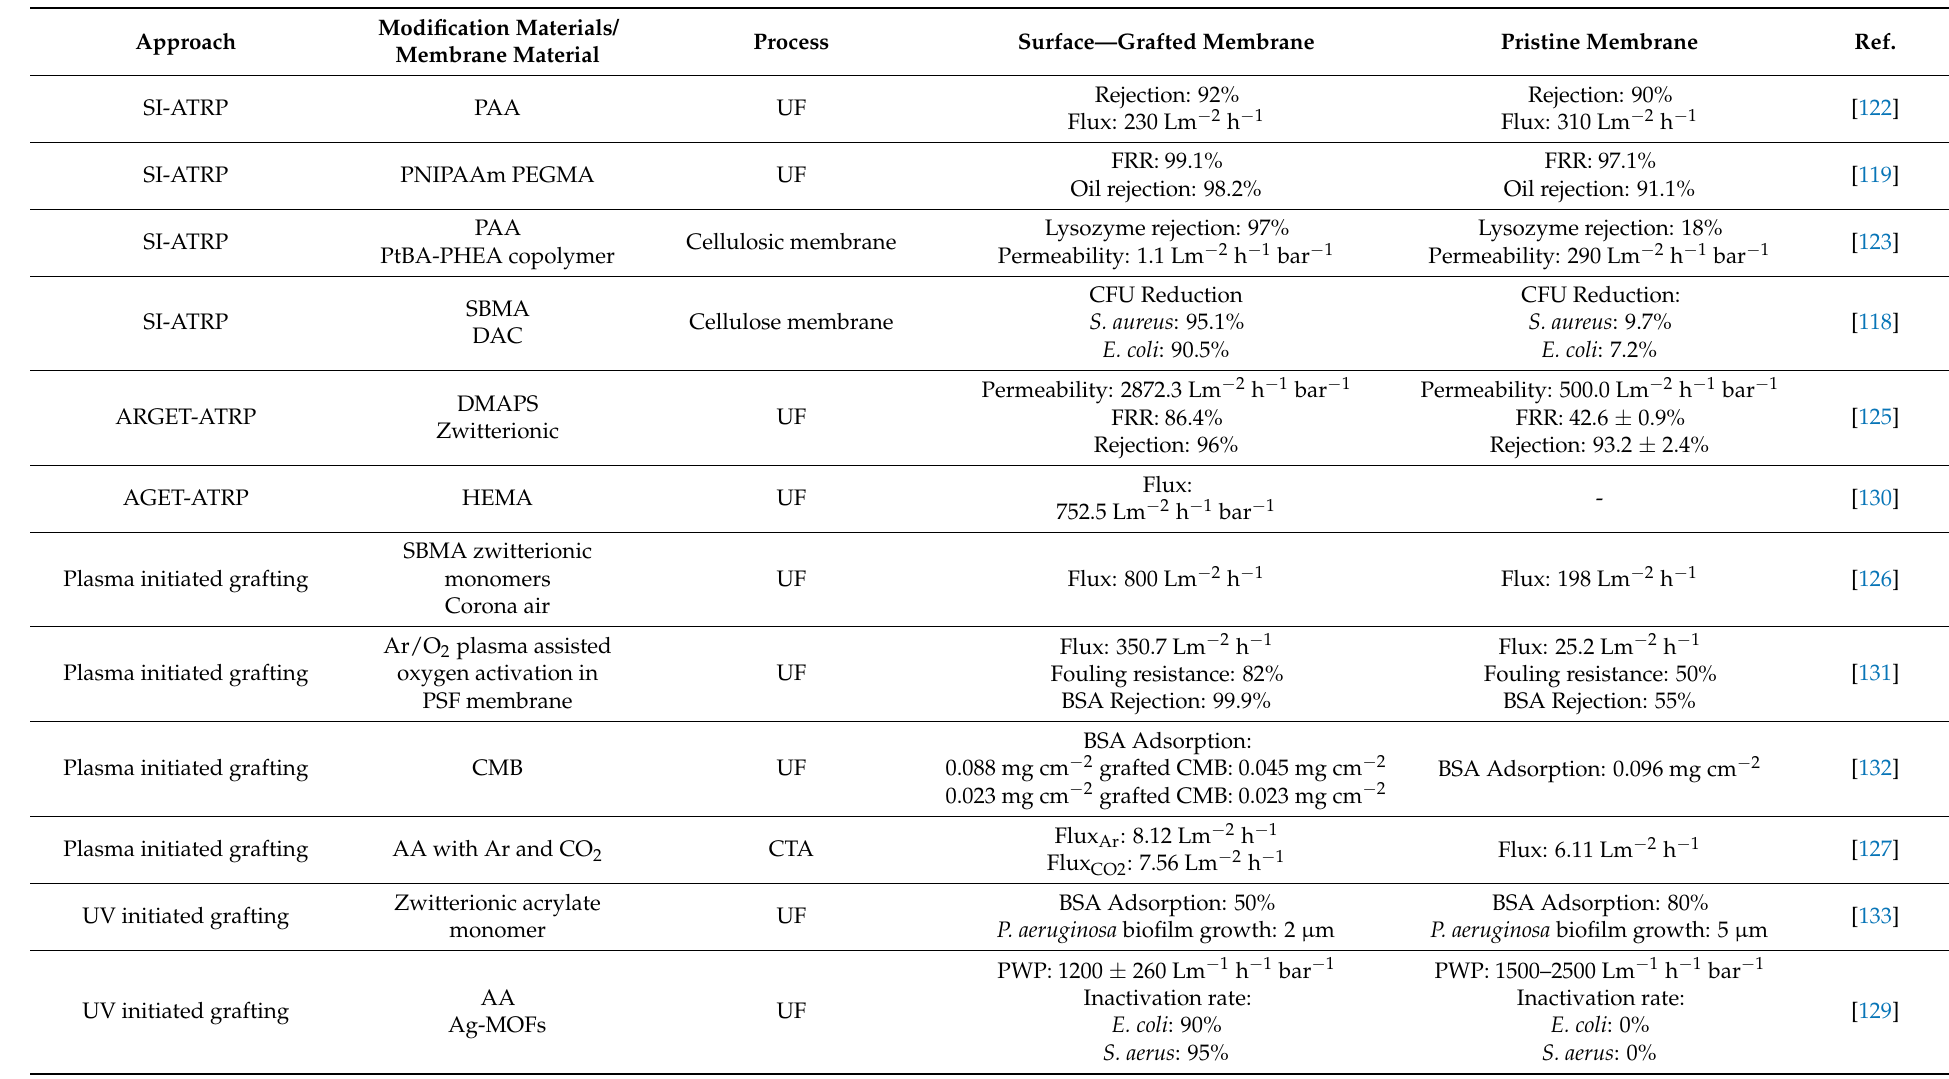
Table 2. Performance evaluation of modified and pristine asymmetric integrally skin